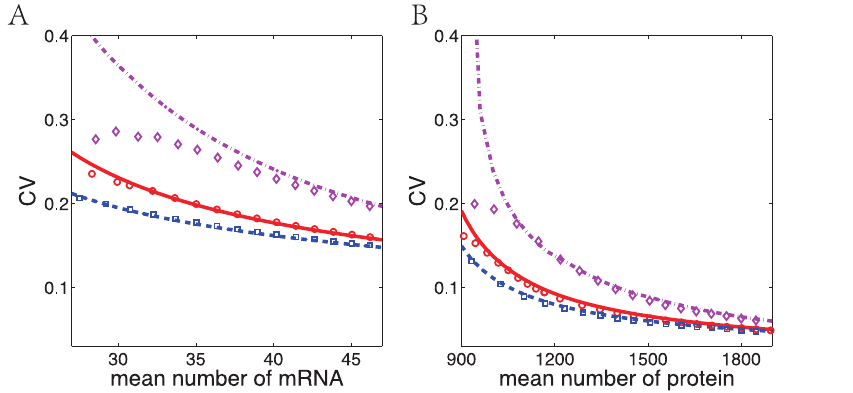
Figure 6. The coefficient of variation (CV) versus mean number of (A) mRNA and (B) protein induced by varying transcription rate a with different promoter transition rates. The lines and discrete dots correspond to analytical results and MC simulations, respectively. The results with fast promoter transition rates are shown in blue dash-dotted line and % , medium rates in red solid line and 0 , and slow rates in magenta dashed line and . The parameters here are the same as in Fig. 4 (A,C).